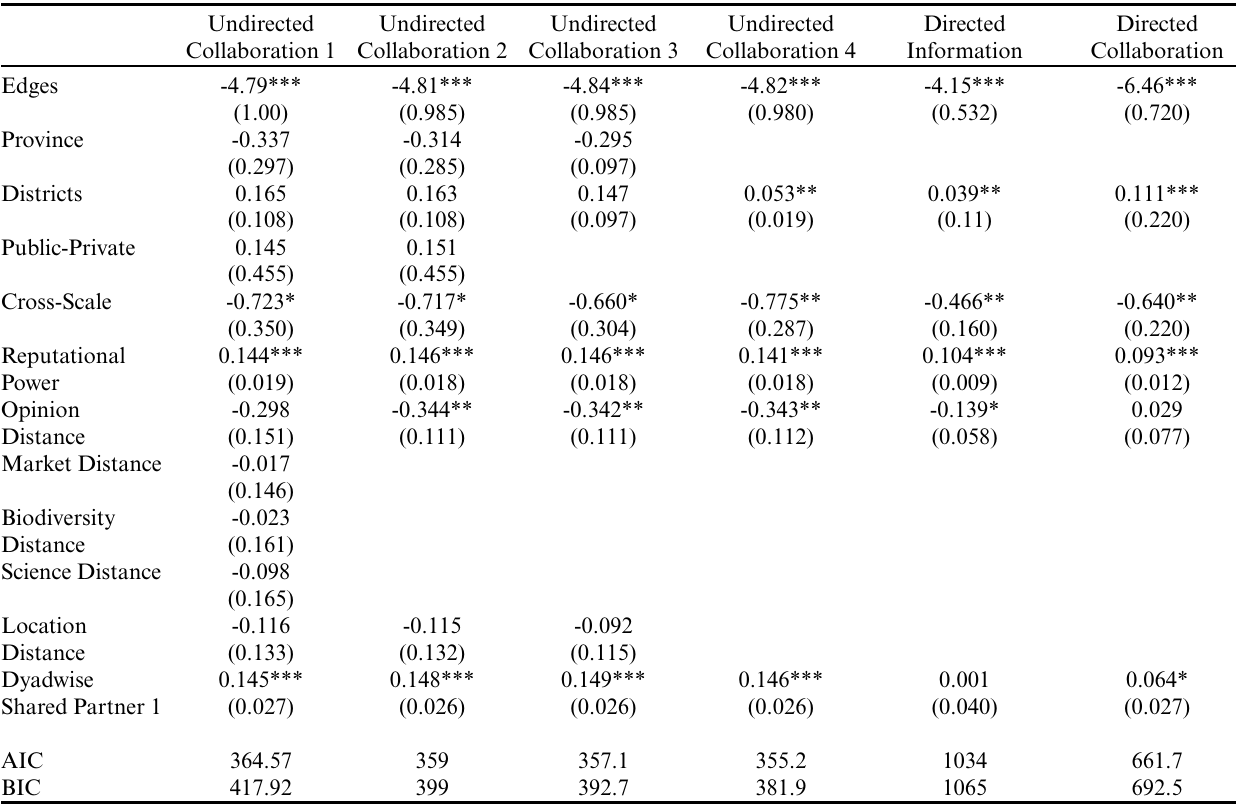
Table 2 . Markov Chain Monte Carlo Maximum Likelihood Estimation of Exponential Random Graph Model parameters for the REDD+ policy network in Central Kalimantan. * = Significant at 0.05; ** = Significant at 0.01; *** = Significant at 0.001. Estimated with the ERGM package (Hunter et al. 2008a) in R 3.0.1 (R Core Team